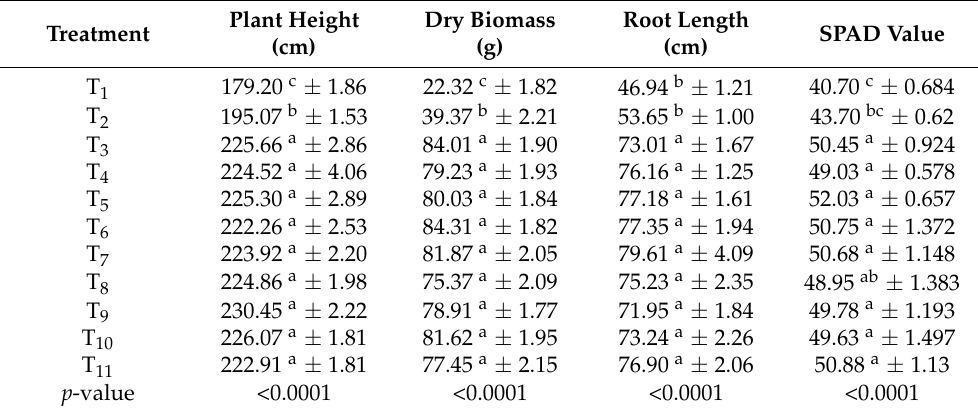
Table 5. Effect of treatments on plant growth.